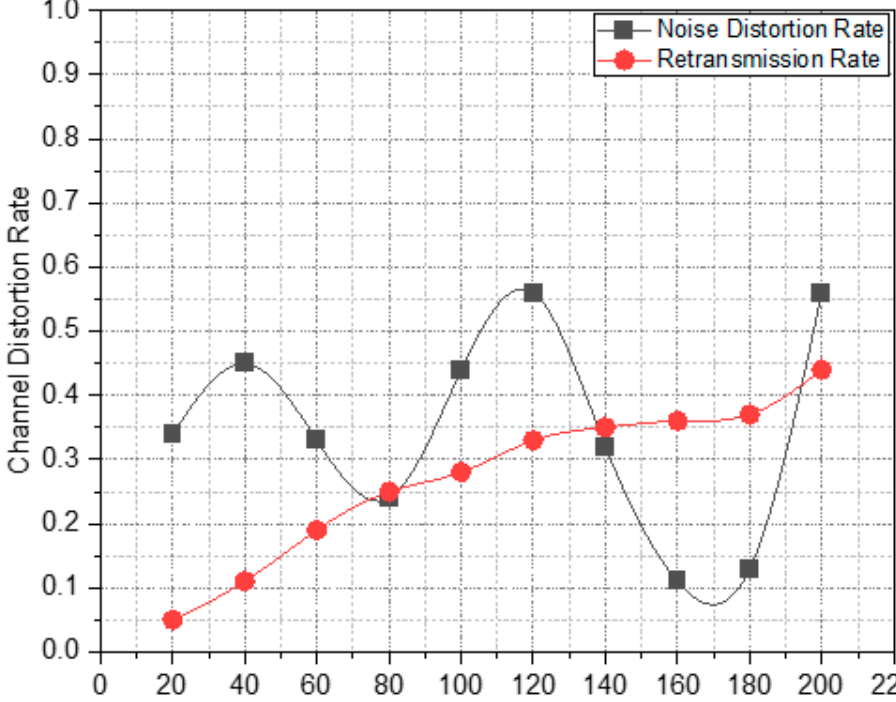
Figure 6. Channel distortion